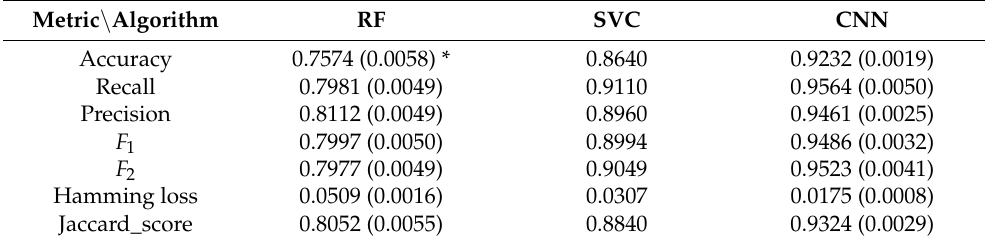
Table 8. Classification performance in experiment 4 after swapping the training and test sets. Metric \